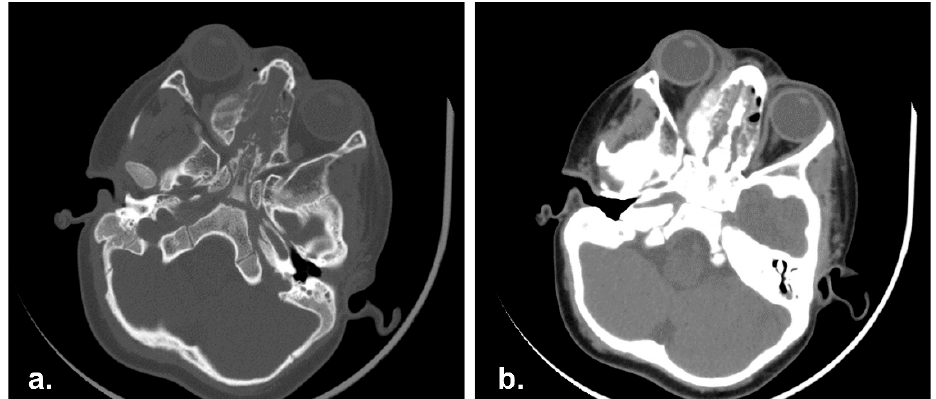
Figure 4. Pre-operative Computed Tomography scan (CT) showing an ethmoidal mass involving the nasal septum and bilateral lamina papyracea. ( a ) Bone and ( b ) soft tissue CT algorithm.